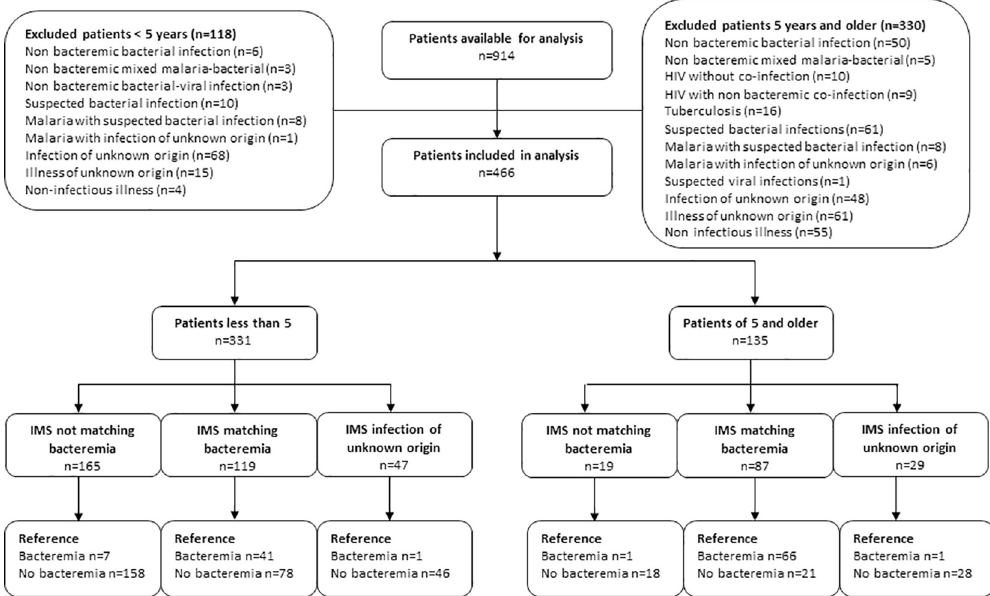
Fig 2. Diagnostic accuracy of the IMS for bacteremia by age group. Legend: IMS: Infection Manager System | “Reference” refers to blood culture confirmed